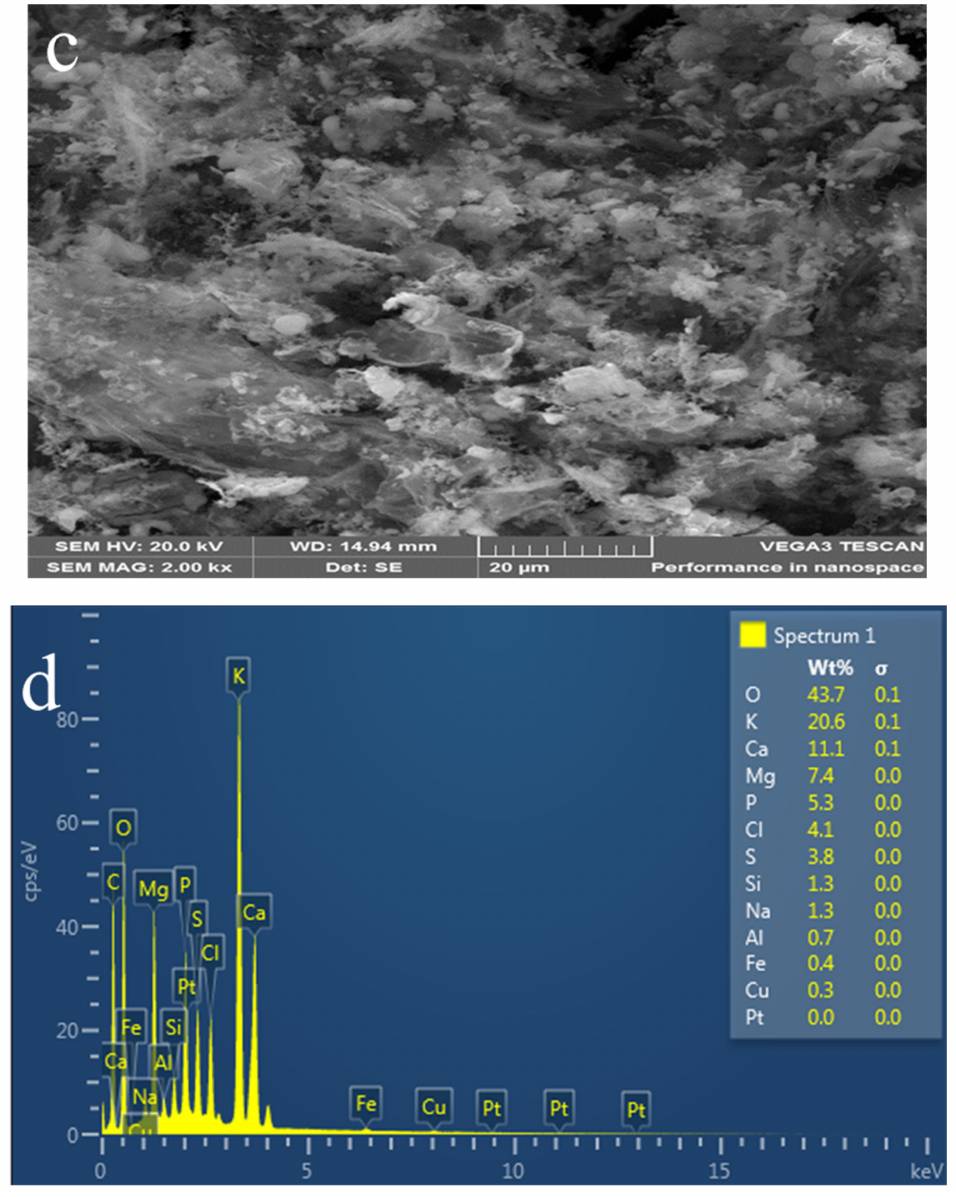
Figure 3. SEM micrographs of the biochar of ( a ) @PdCassCat, ( b ) @PtCassCat, ( c ) control sample, and ( d ) EDX of the